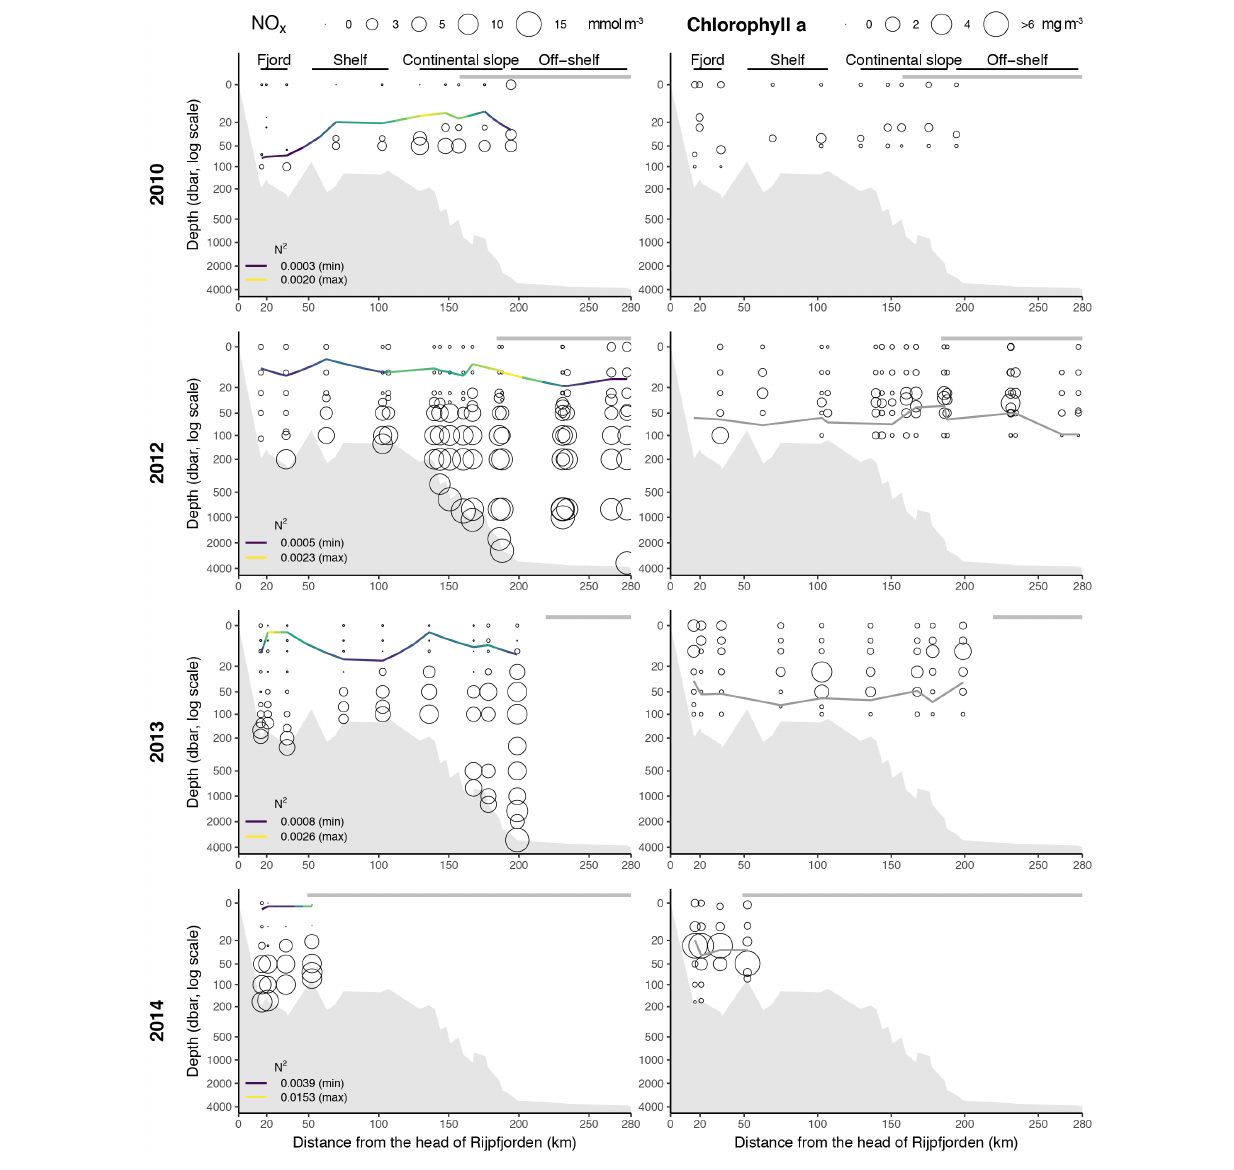
FIGURE 5 | Nitrate and nitrite (NO x ) (left panels) and Chlorophyll a (right panels) concentrations along the Rijpfjorden transect. Size of bubbles relates to concentration (mmol m − 3 and mg m − 3 , respectively). Thin line in left panels indicates depth of maximum stratification with minimum and maximum levels specified (colors and numbers). Thin gray line in right panels indicates euphotic zone depth (i.e., CTD depth with PAR value 0.47 µ mol photons m − 2 s − 1 , which is 0.1% of surface radiance value for the CTD with surface irradiance measurement). The thick gray horizontal line indicates the extent of consolidated pack